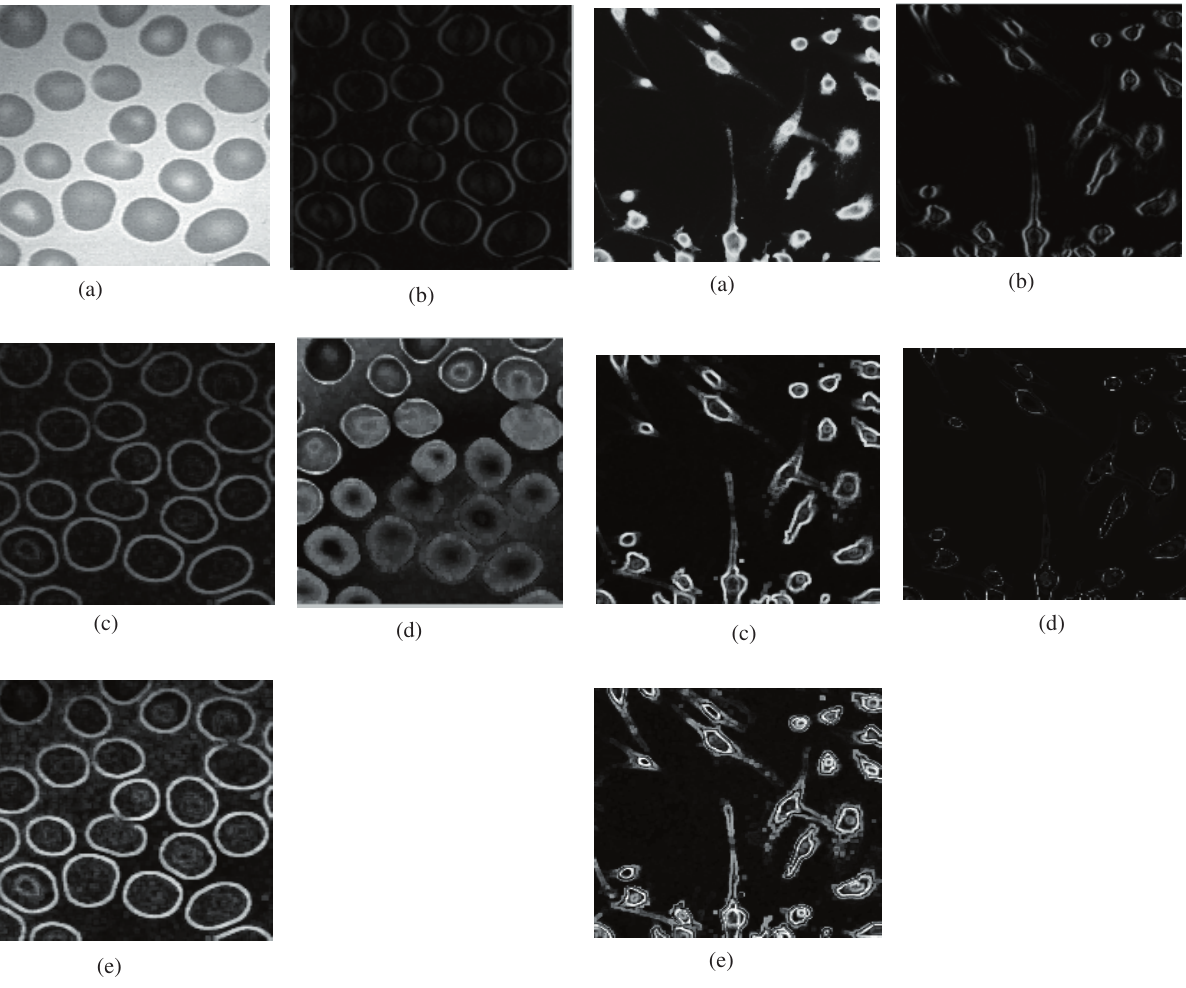
Fig. 4. : a) blood cell image, b) edge image using fuzzy morphology, c) edge image using the interval valued fuzzy set, d) edge image by Chaira and Ray, e) edge image using proposed